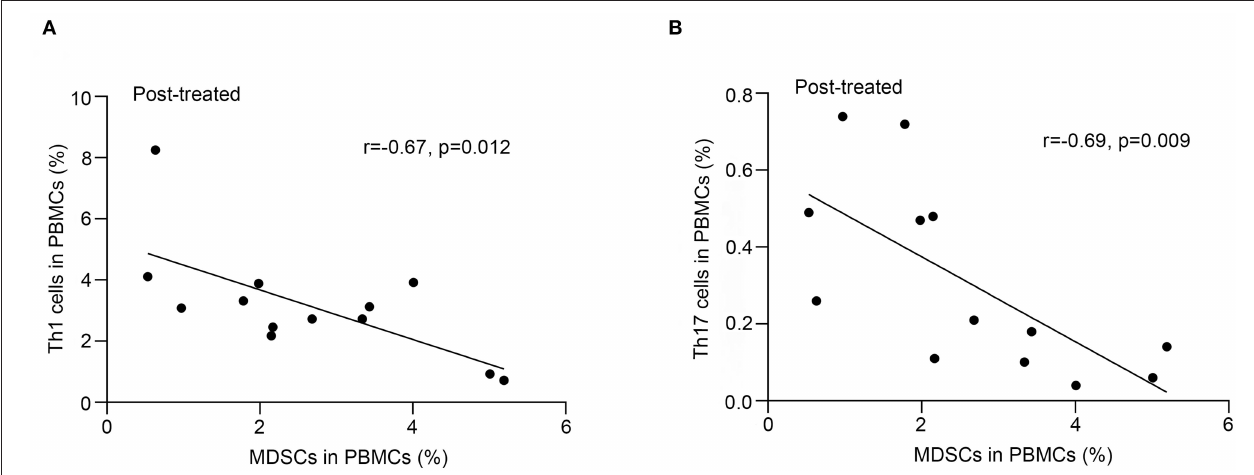
FIGURE 3 | Correlation of frequency of MDSC in PBMCs with that of Th17 and Th1 cells after immunotherapy. Frequency of MDSCs in PBMCs negatively correlated with that of Th1 cells (A) or Th17 cells (B) in PBMCs from 13 patients after immunotherapy ( n =